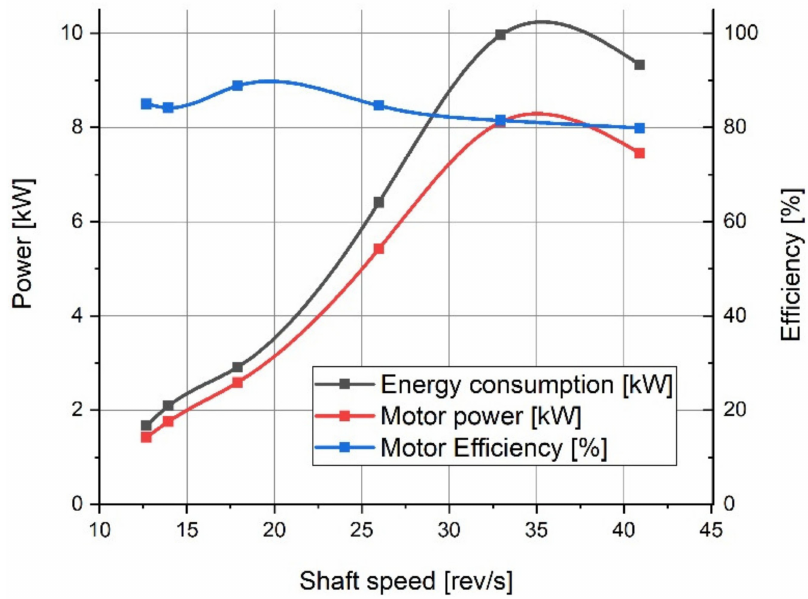
Figure 4. Power and e ffi ciency of a 10 kW electric motor as a function of motor shaft speed. The belt drive design made use of experimental findings, in which various types of belt drives produced by leading manufactures were investigated, with tests performed on a classic straight tooth synchronous belt, bevel belts (herringbone belt) and a classic a set of V-belts. The measurements confirmed that the highest e ffi ciency and minimum noise emissions of 75 dB or less characterized the modern V-belt (Figure 5), whereas the straight tooth belt emitted noise at 95 dB. Consequently, 85% e ffi ciency was used in calculating the power demand, with the assumption that the electric motor would be working at approximately 4 kW, which corresponds to a speed of over 5 km / h.